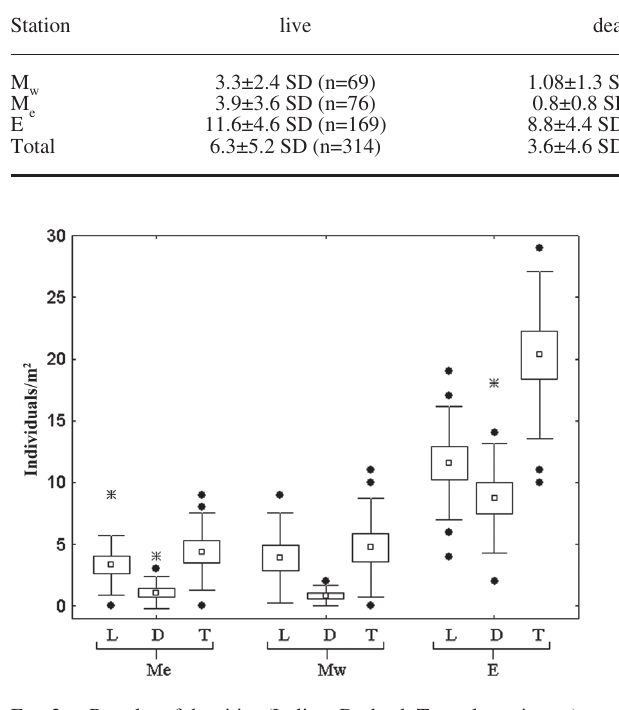
Fig . 2. − Boxplot of densities (l, live; d, dead; t, total specimens).